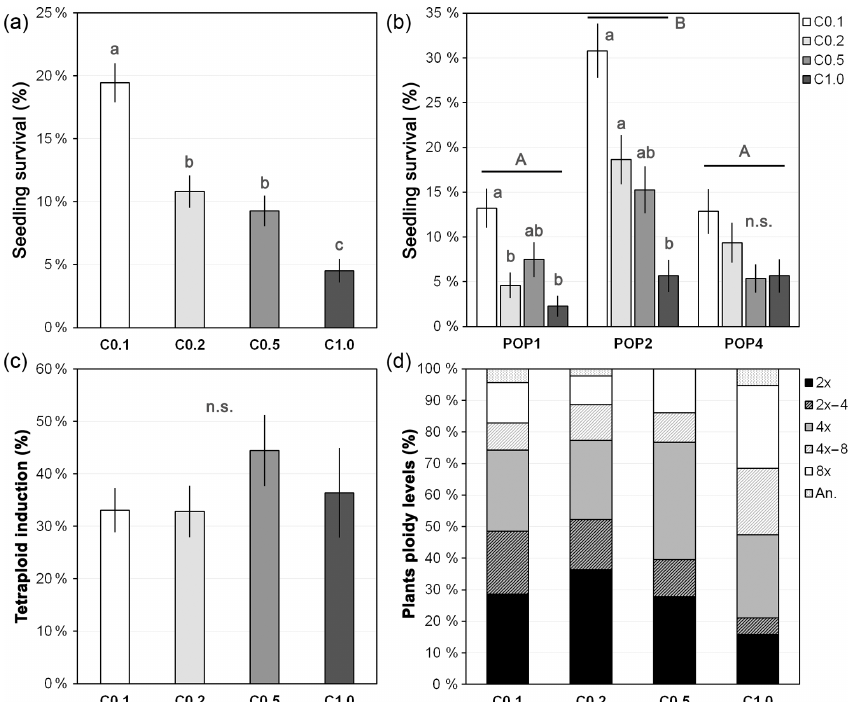
Figure 3. Colchicine treatment effect on seedling survival, synthetic tetraploid induction and ploidy levels of treated seedlings. (a) Overall seedling survival for each treatment with different colchicine concentrations, (b) seedling survival for each treatment within each studied population, (c) synthetic tetraploid induction rate per treatment and (d) ploidy levels of the plants after treating seedlings with different colchicine concentrations. Treatment with different colchicine concentrations: C0.1, colchicine at 0.1%; C0.2, colchicine at 0.2%; C0.5, colchicine at 0.5%; C1.0, colchicine at 1.0%. Ploidy levels: 2 x , DNA diploid; 2 x –4 x , diploid-tetraploid mixoploids; 4 x , DNA tetraploid; 4 x –8 x , tetraploid-octoploid mixoploids; 8 x , DNA octoploid; an., DNA aneuploids. Values are given in percentage as mean and standard error of the mean (in a–c ) or percentage from the total (in d ). Different lower-case letters denote significant differences among treatments, including the total comparison (in a ) and among treatments within population (in b ) at P < 0 . 05; different upper-case letters denote significant differences among populations at P < 0 . 05; n.s. denotes non-significant differences between treatments at P > 0 .